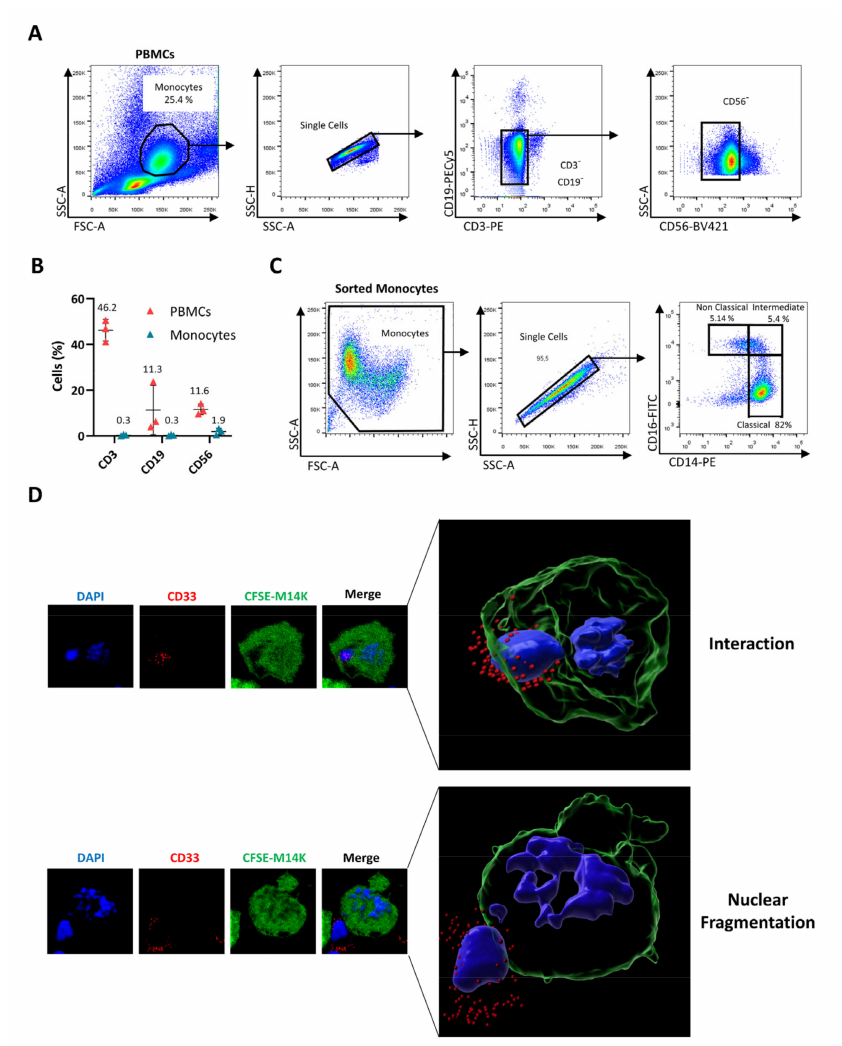
Figure 2. Cell-to-cell contact between blood-derived monocytes and M14K cells. ( A ) PBMCs were isolated from buffy coats of healthy donors by Ficoll gradient centrifugation. After labeling with CD3-PE, CD19-PECy5, and CD56-BV421 antibodies, monocytes were negatively sorted by flow cytometry. ( B ) Flow cytometry analysis of PBMCs and sorted monocytes labeled with CD3-PE, CD19-PECy5, and CD56-BV421 antibodies. The graph represents the percentages of labeled events before (PBMCs) and after cell sorting (Sorted Monocytes). ( C ) Isolated monocytes were labeled with anti-CD14-PE and anti-CD16-FITC. Representative plots are shown. ( D ) M14K cells were labeled with CFSE, incubated for 4 h, and then cocultured with freshly isolated monocytes at a ratio of 4/1. After 24 h of culture on coverslips, cells were labeled with an anti-CD33 primary antibody followed by an Alexa Fluor 647 conjugate. Cells were further fixed with PFA 4%, stained with DAPI, and analyzed with a HR confocal microscope. Images were computed with Imaris. Representative interactions between CFSE-positive M14K cells (in green) and CD33-labeled monocytes (in red) are shown. Nuclei fragmentation is revealed by DAPI staining (in